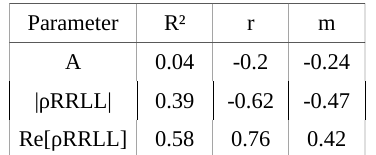
Table 3. Correlation parameters between roughness estimator and ks values after masking out areas with a